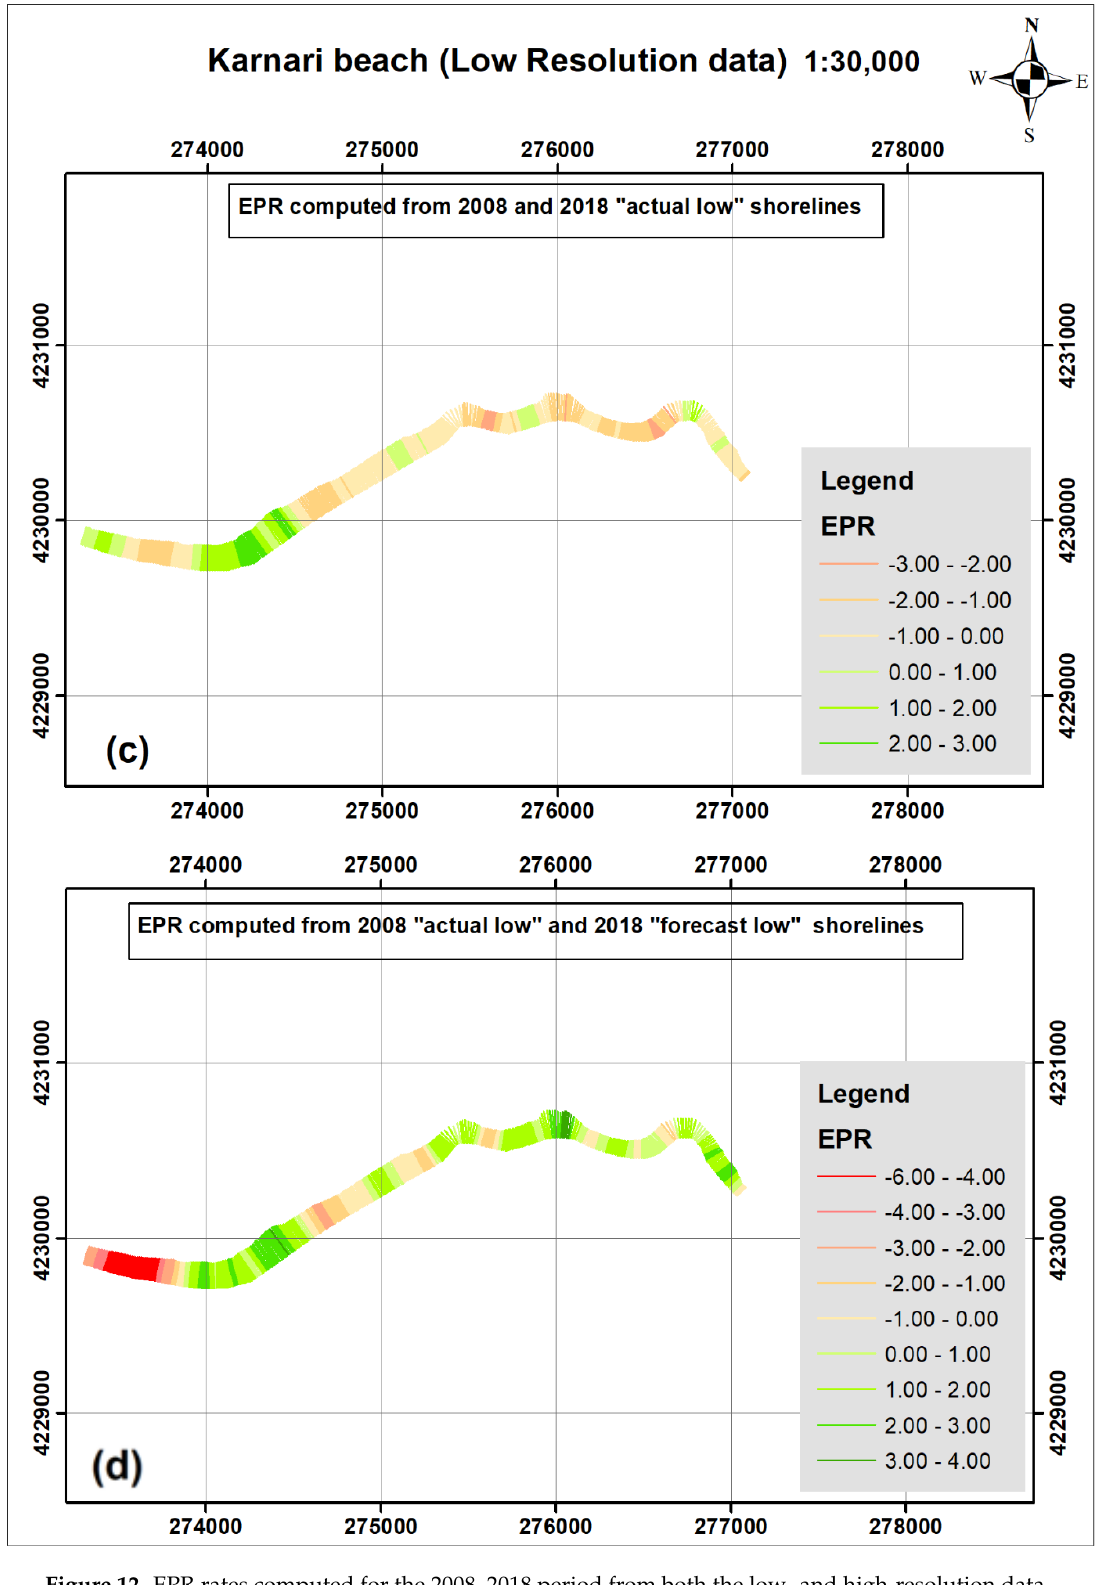
Figure 12. EPR rates computed for the 2008–2018 period from both the low- and high-resolution data using the 2008 and 2018 “actual” shorelines and the 2018 “forecasted” shorelines for Karnari beach. The results for Karnari beach from the “actual high” resolution data show that a large area that extends to the northeast is being eroded, while accretion is taking place towards the western part of